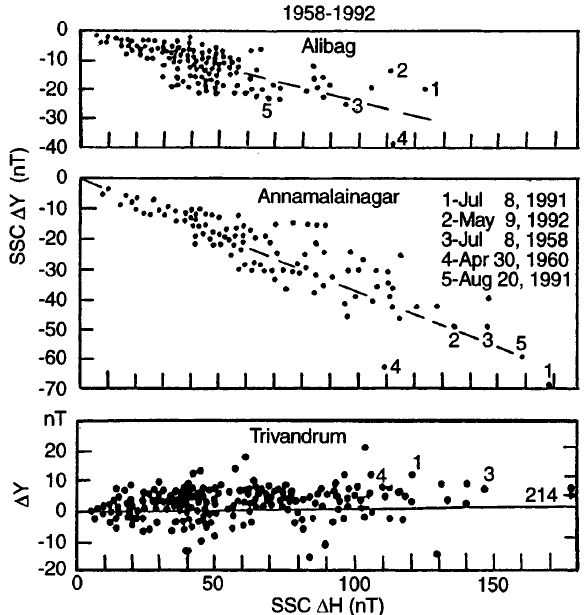
Fig. 7. Relationship between amplitudes of SSC D Y and D H at the stations Annamalainagar ( ANN ) Trivandrum ( TRD ) and Alibag ( ABG ) of SSCs